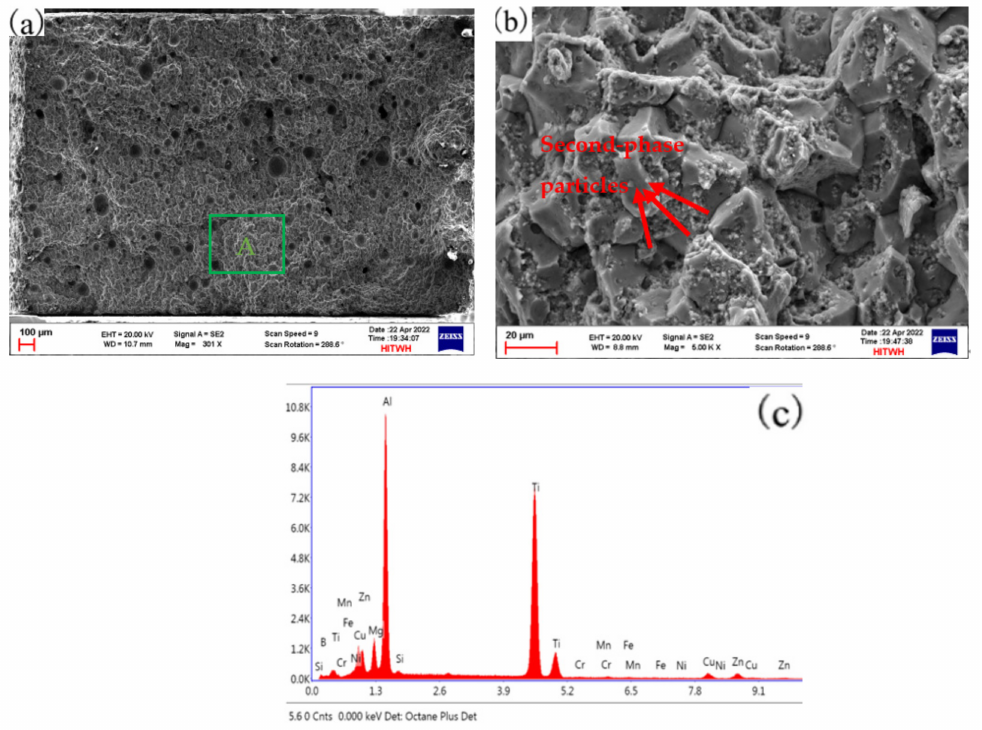
Figure 15. EDS scanning result of fracture morphology of tensile sample. ( a ) Fracture morphology. ( b ) Fracture morphology of zone A. ( c ) EDS scanning